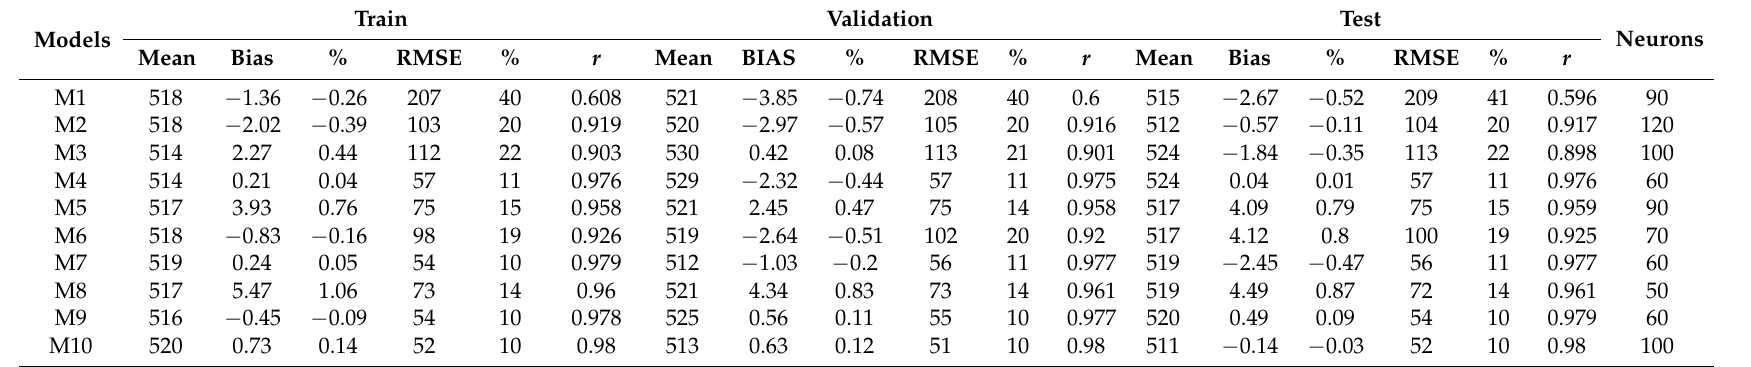
Table A2. As in Table A1, but for Enjaksor tower